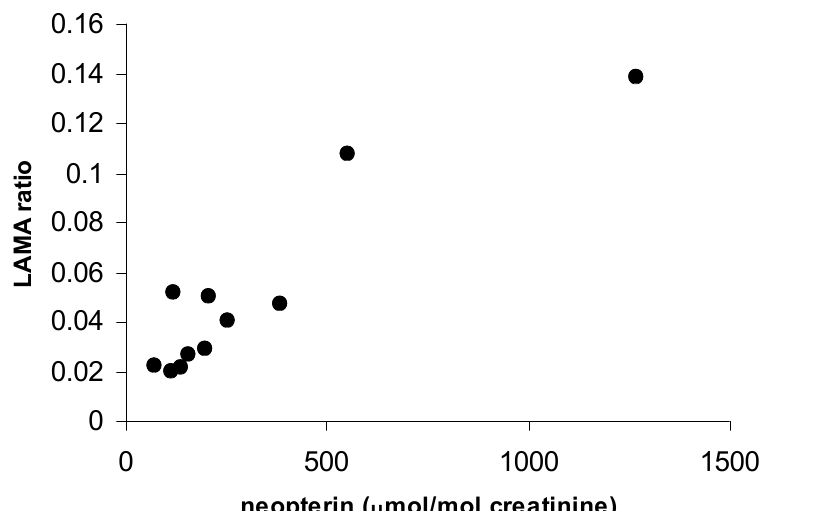
Figure 3. Correlation between urinary neopterin and lactulose/mannitol ratio. Shown is the correlation between urinary neopterin and lactulose/mannitol (LAMA) ratio in patients evaluated before the start of gefitinib therapy = 0.75, p = 0.008, n = 11). Lactulose/mannitol ratio was not evaluable in 2 patients because of high background (r s mannitol